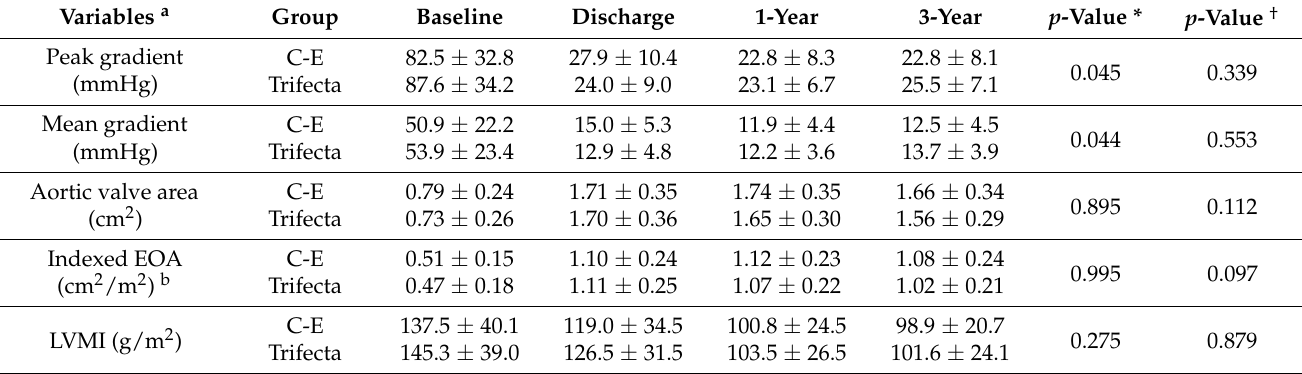
Table 3. Echocardiographic results of the matched patients at each time point.